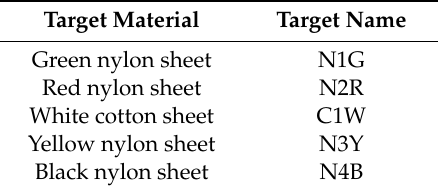
Table 1. Target materials and naming convention used in the